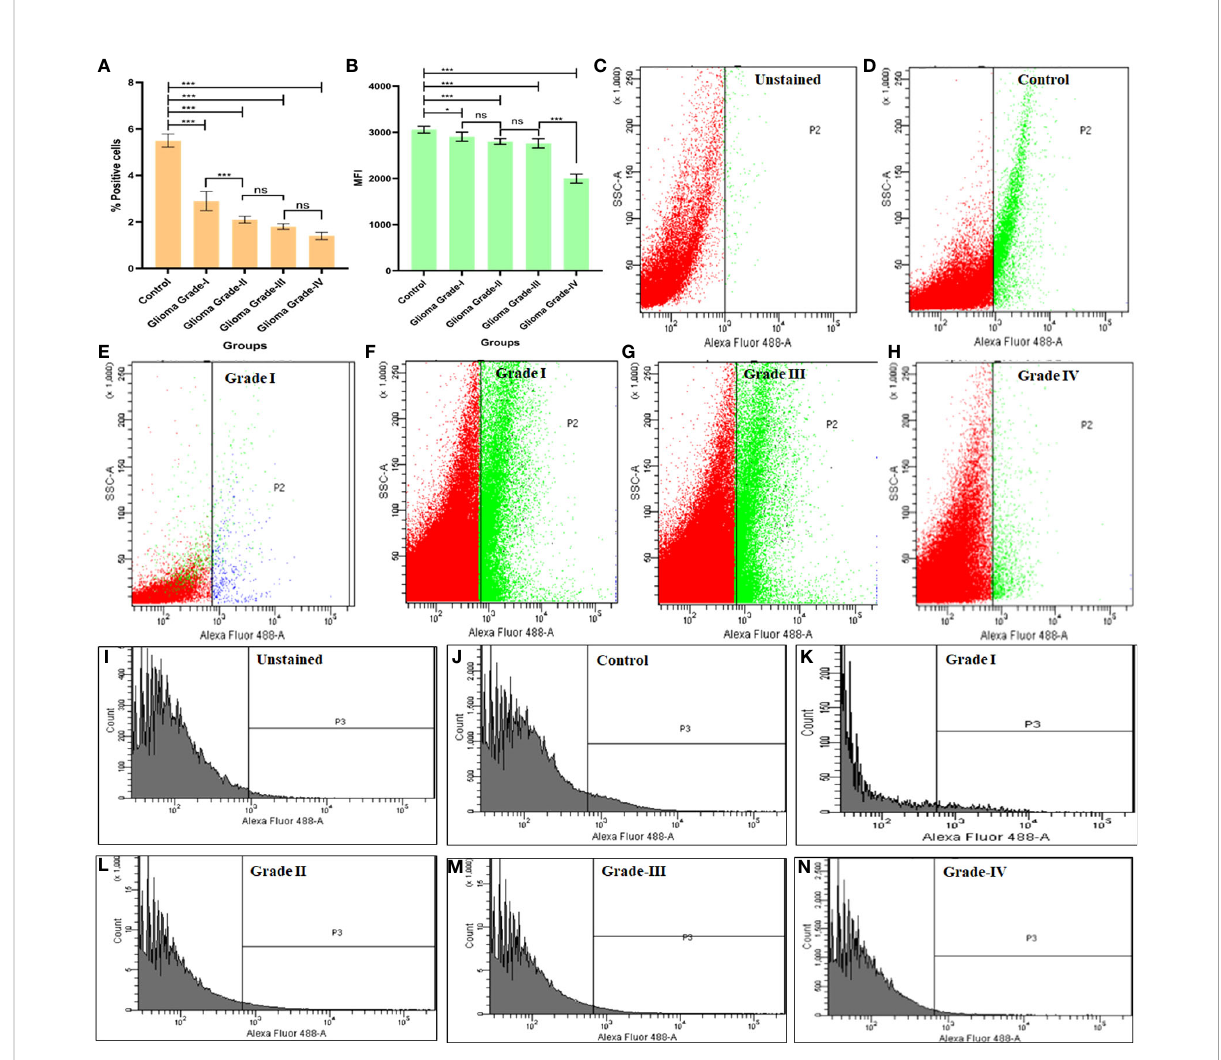
FIGURE 5 Flowcytometric measurement of cytochrome C protein in different grades of Glioma. (A) Graph represents % positive cells in different grades of glioma in comparison to normal brain cells. (B) Graph represents the mean fl uorescent intensity (MFI) of Cyto C in different grades of glioma in comparison to normal brain cells. (C-H) Dot plot describes changes in expression of apoptotic protein Cyto C in different grades of glioma in comparison to normal brain cells. (I-N) Histogram represents changes in expression of Cyto C protein in different grades of glioma in comparison to normal brain cells. n=6 per group. A value of *p < 0.05, ***p < 0.001, ns not-signi fi cant(p >